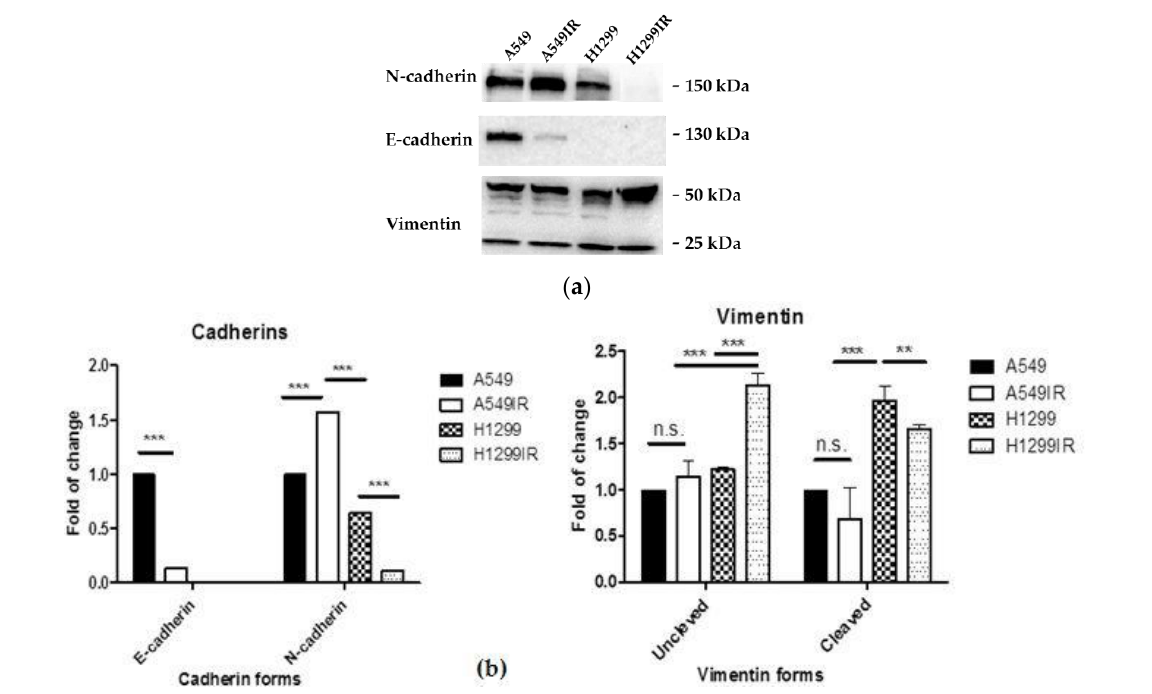
Figure 3. Expression of EMT-related markers in parental and MFR-surviving NSCLC sublines. Western Blot ( a ) and quantification ( b ) analysis of E-cadherin, N-cadherin and Vimentin expression. *** p < 0.001; ** p < 0.05; n.s. non-significant. Data are means ± SD of three independent experiments.